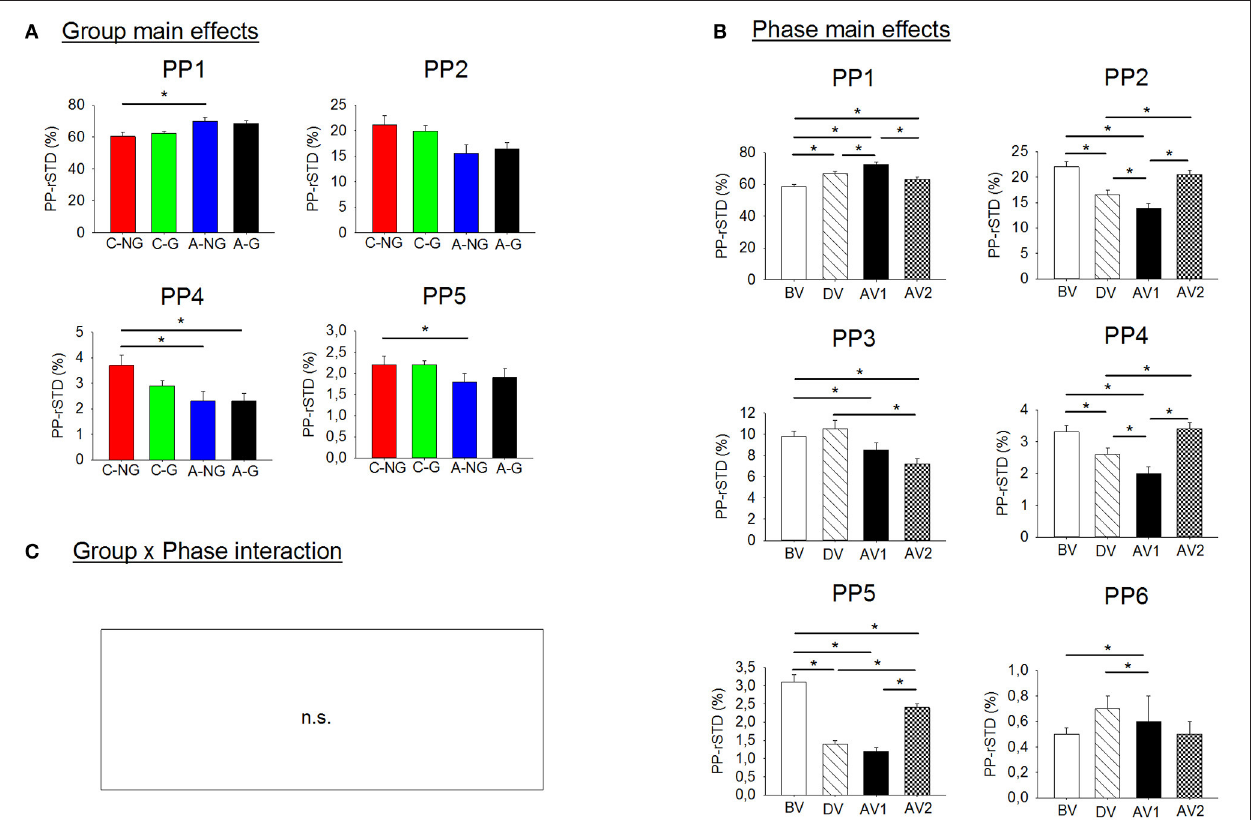
FIGURE 2 | (A) Significant group main effects in the PPs (principal postural movement components). Means and standard deviations were plotted by group (children non-gymnasts, C-NG; children gymnasts, C-G; adults non-gymnasts, A-NG; and adults gymnasts, A-G); (B) significant phase main effects in the PP. Means and standard deviations were plotted by phase (BV, before vibration; DV, during vibration; AV1, after vibration early phase; AV2, after vibration late phase); and (C) group x phase interactions were not significant (n.s.). Asterisks (*) indicate significant difference in the post-hoc